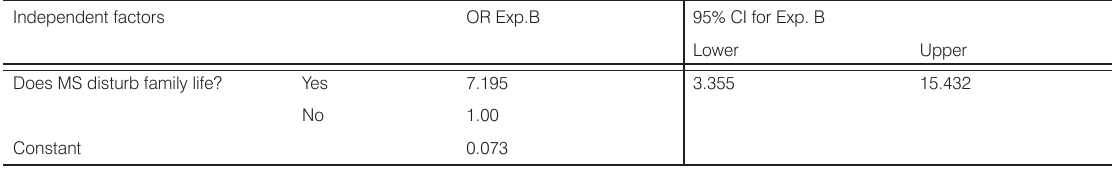
Table 3. Relation between depression and answers to questions regarding life activities.